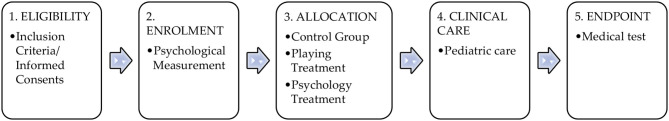
Representation of the study design and phases of the protocol.